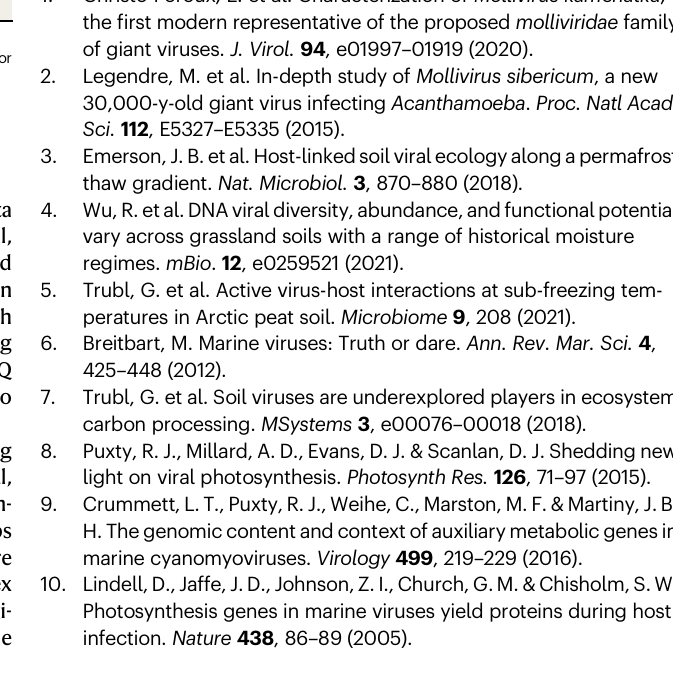
* Numbers in parenthesesrelateto the highest resolution shell. Inall cases thecrystalsare isomorphous withV-Csn apo1crystals. # R meas is theredundancy-independentmergingRfactor andR pim istheprecision-indicating merging R factor 71 . $ Percentageofcorrelation between intensities from randomhalf-setsofdata 73 . & R free was calculatedwith5%of the re fl ections. ± Calculated byMOLPROBITY 74